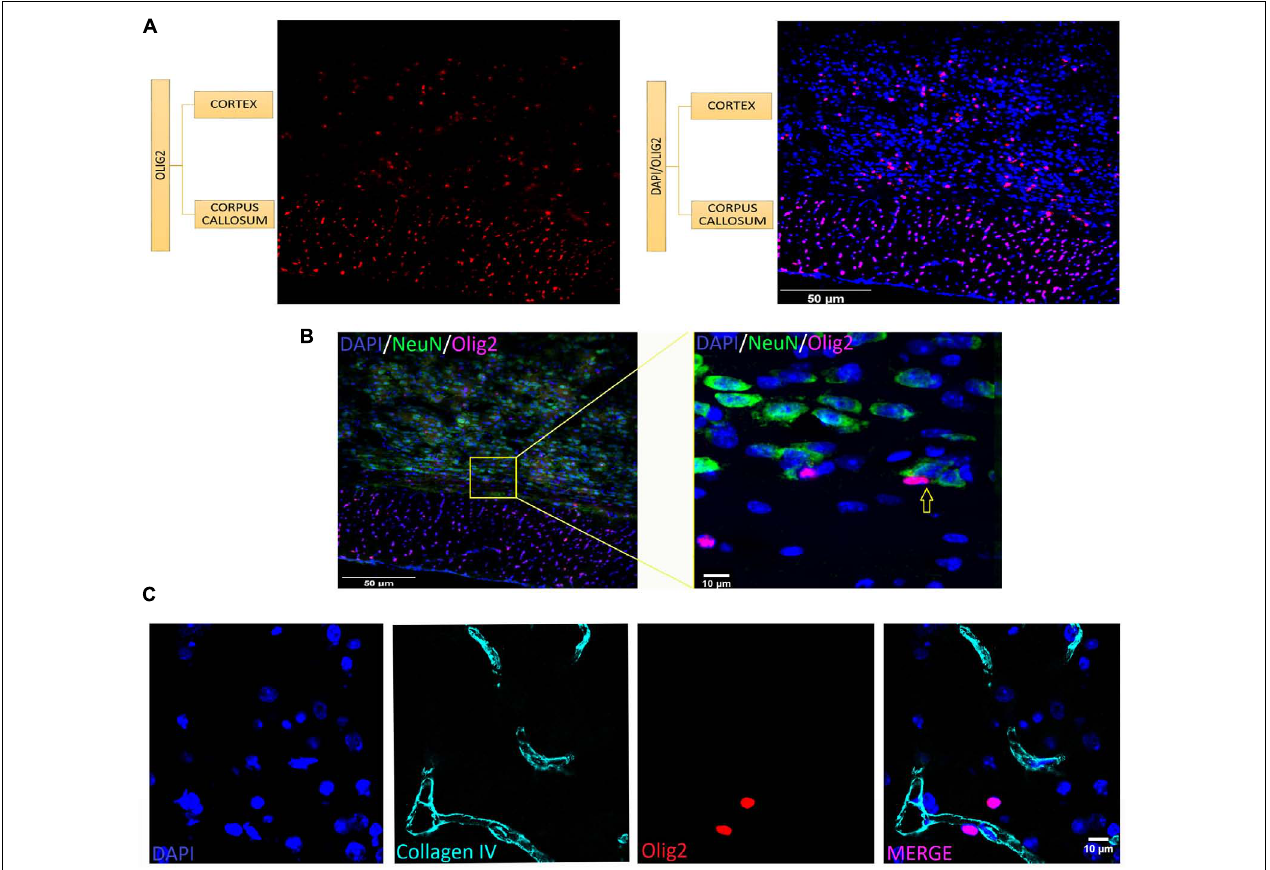
FIGURE 3 | Oligodendrocytes are present at different densities and tissue locations in the brain. (A) Colocalization of Olig2 (red) and DAPI (blue) in gray (cerebral cortex) and white matter (corpus callosum). Notice higher density in the white matter. (B) Olig2+ cell (violet) in close apposition to NeuN+ cells (green) indicated in yellow arrow at a high magnification from a spread view, showing oligodendrocytes which are neuronal satellites. (C) Co-staining of vasculature basement membrane Collagen IV (cyan) and Olig2 (red) in the cerebral cortex showing perivascular oligodendrocytes (which are very close to blood vessels). Scale bars: 50 µ m (A,B) , 10 µ m (B,C)